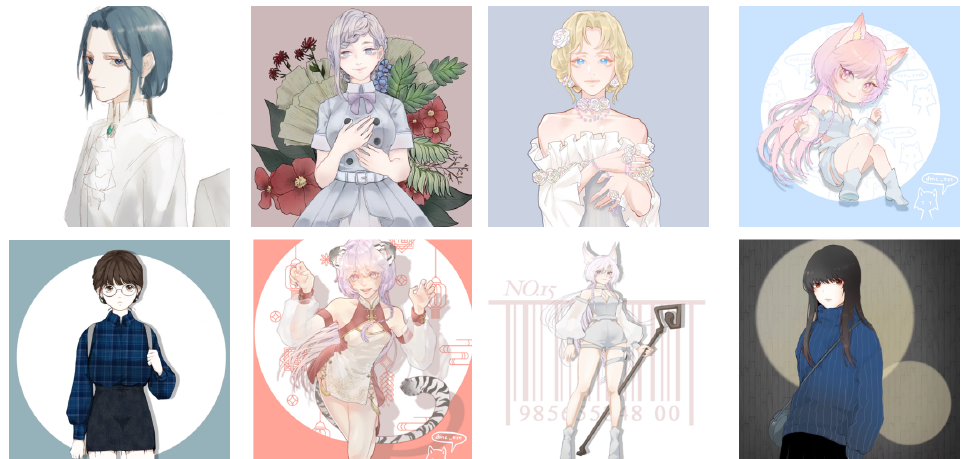
Figure 17. Example images from the anime character image data (full-body and half-body; from Pixiv). HR is 512 × 512, LR are 64 × 64, 128 × 128, 256 × 256. The images are adopted from